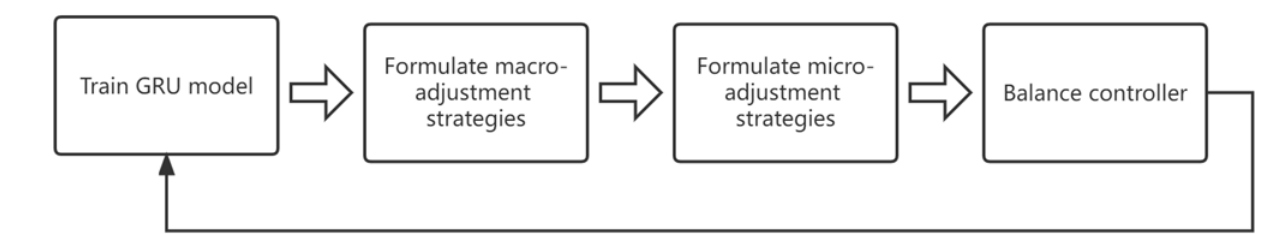
Figure 1. The flow chart of temperature and humidity regulation process includes four steps: training GRU model, formulating macro-adjustment strategies, formulating micro-adjustment strategies, and balance controller.